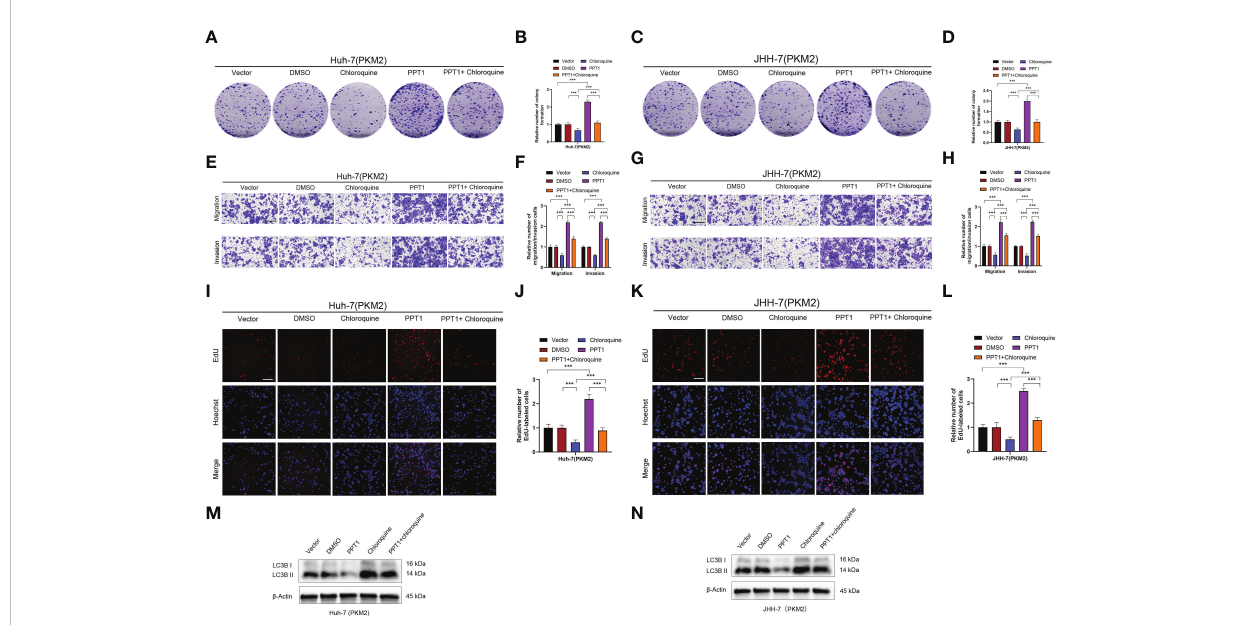
FIGURE 9 PPT1 promotes the proliferation, migration and invasion of HCC via lysosomes in vitro . (A – D) The colony formation was counted in stable overexpression of PKM2 between Huh-7 (A, B) and JHH-7 (C, D) cells. (E – H) Representative images and histogram analysis of Transwell migration and Matrigel invasion assays in stable overexpression of PKM2 between Huh-7 (E, F) and JHH-7 (G, H) cells. Scale bars: 100 m m. (I-L) Representative images and histogram analysis of EdU assays in stable overexpression of PKM2 between Huh-7 (I, J) and JHH-7 (K, L) cells. Scale bars: 100 m m. (M, N) Western blotting analysis of PPT1 and LC3B in stable overexpression of PKM2 between Huh-7 (M) and JHH-7 (N) cells. b -Actin was used as a loading control. The error bars are expressed as the mean ± SD of three independent experiments. (***: P <